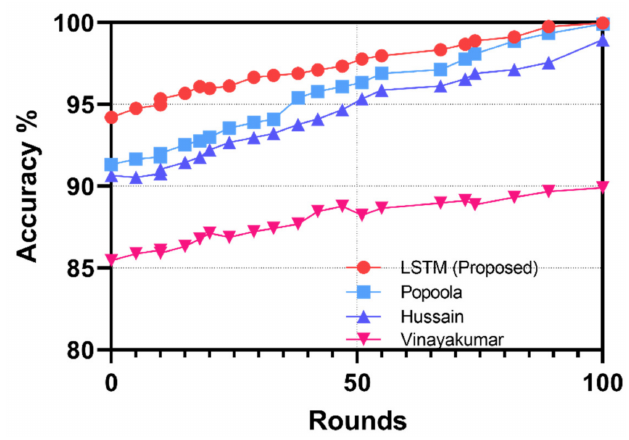
Figure 8. Comparison analysis of accuracy in botnet detection with Popoola. Table 6. Quantitative Analysis of the Botnet-detection model with existing